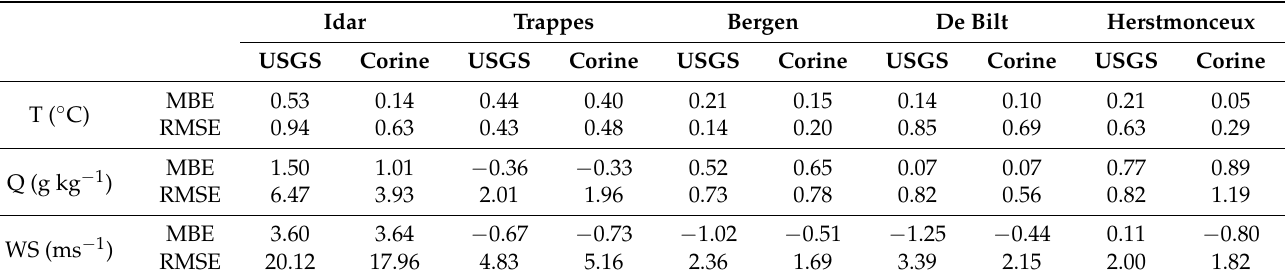
Figure 9. Vertical profile of bias in wind speed over five radiosonde stations (Idar, Trappes, Bergen, De Bilt and Herstmonceux) on 18 August 2011 at 12 UTC. The values by WRF_USGS are presented in red colour, and the values by WRF_CLC are given in green colour. Table 2. Mean bias error (MBE) and Root-mean-square error (RMSE) in the model-simulated meteoro- logical profiles of Temperature (T), Specific humidity (Q) and Wind speed (WS) over five radiosonde stations between 900–500 hPa on 18 August 2011 at 12